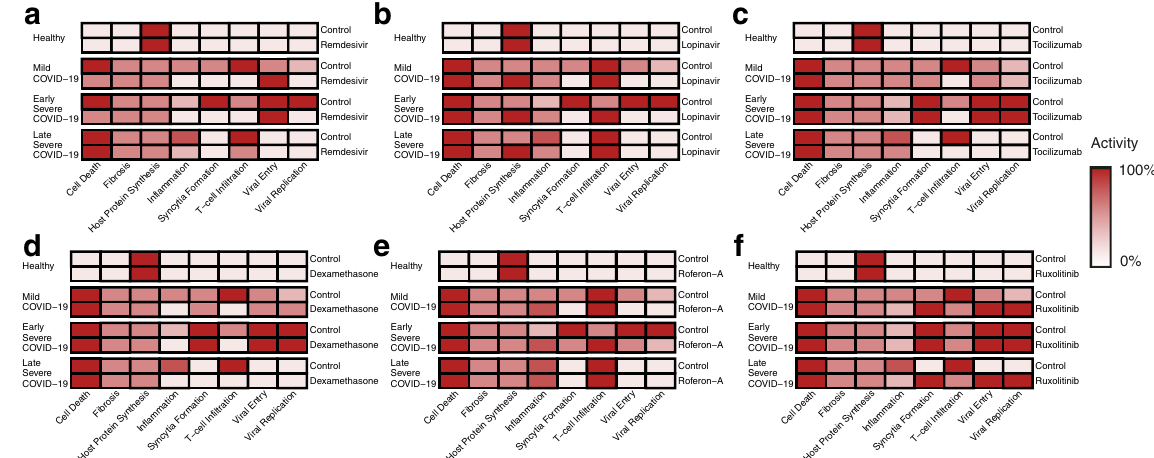
Fig. 3 Model predictions of the effects of known drug treatments for COVID-19. The predicted behaviour of a Remdesivir, b Lopinavir, c Tocilizumab, d Dexamethasone, e Roferon-A and f Ruxolitinib. Colour strength represents the strength of symptoms predicted by the model following drug intervention. All nodes normalised to the maximal level of respective nodes, and range between 0 – 100%. Comparison to known experimental results in Supplementary Table